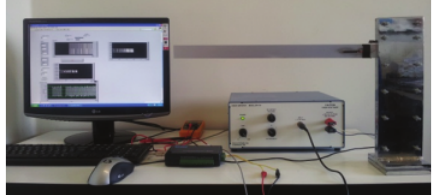
Figure 1: Experiment setup of piezo-laminated at smart materials